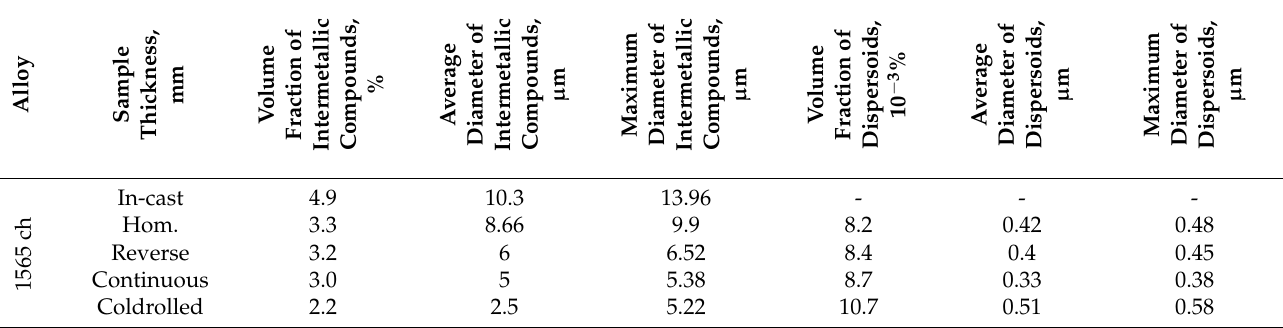
Figure 6. The AlMg 6 Mn 0.7 (1565 ch) particles after hot deformation in the continuous group: ( a ) intermetallic compounds; ( b ) dispersoids.